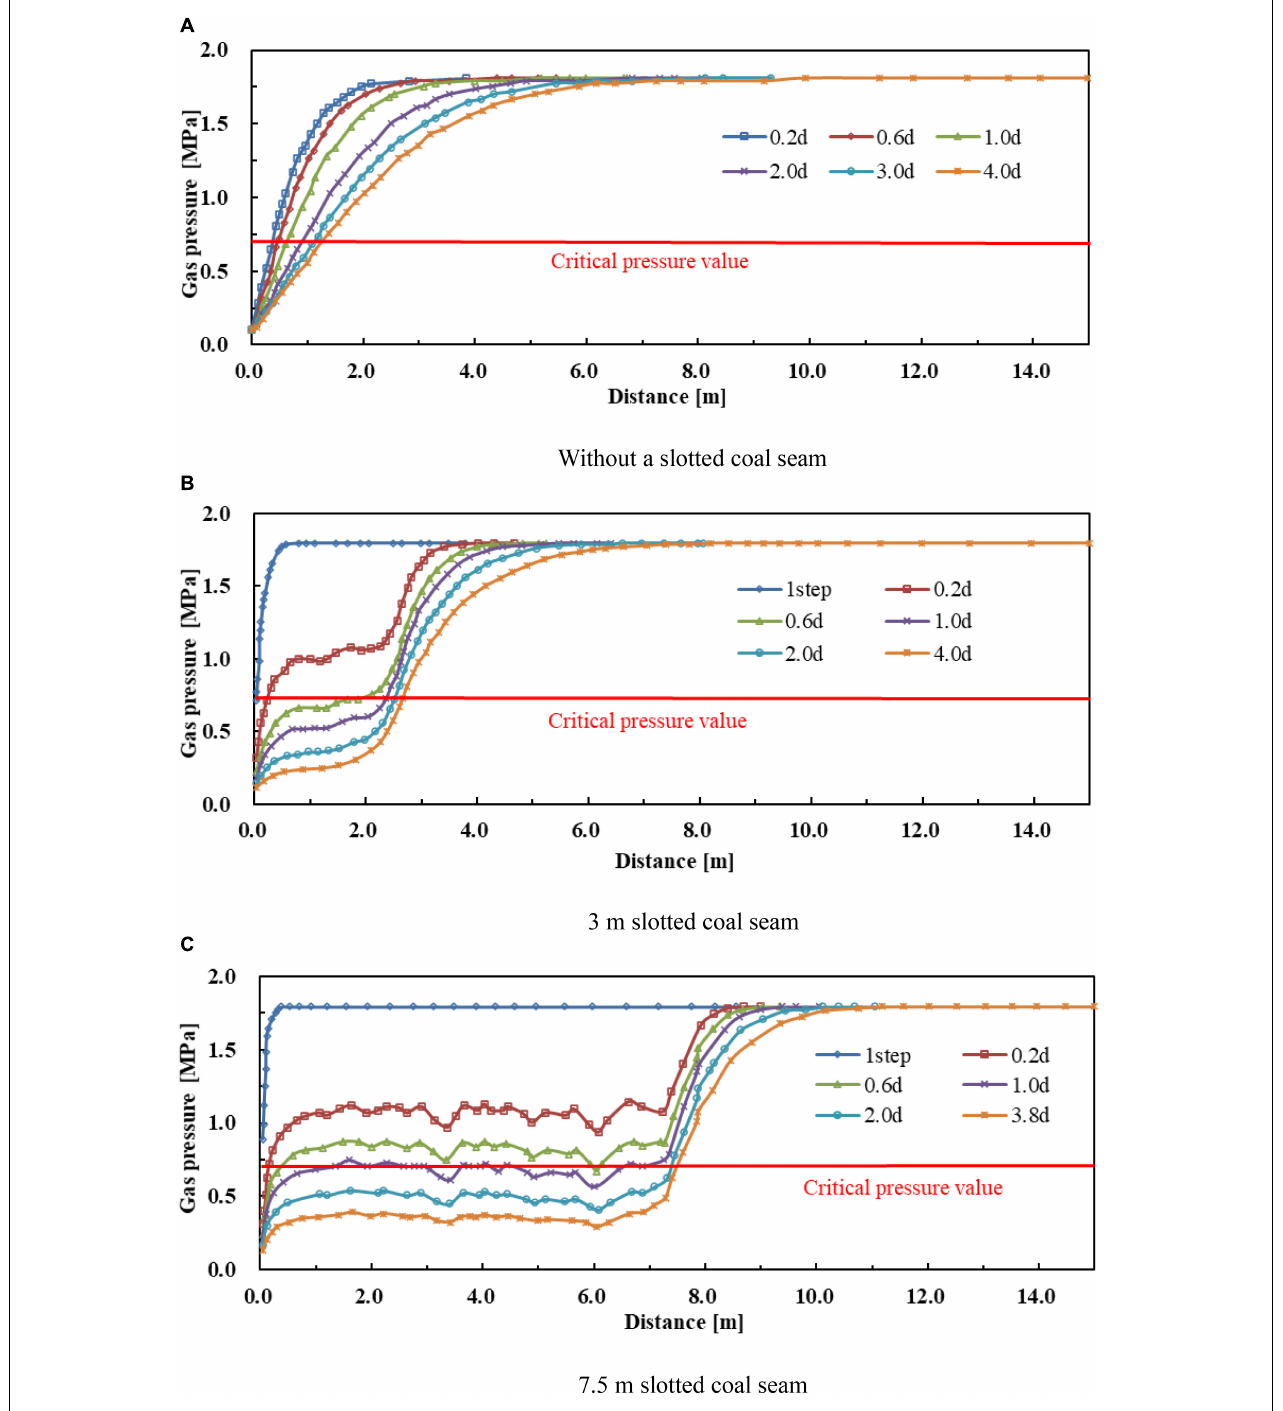
FIGURE 7 | Variation in gas pressure: (A) without a slotted coal seam, (B) 3-m slotted coal seam, and (C) 7.5-m slotted coal seam.